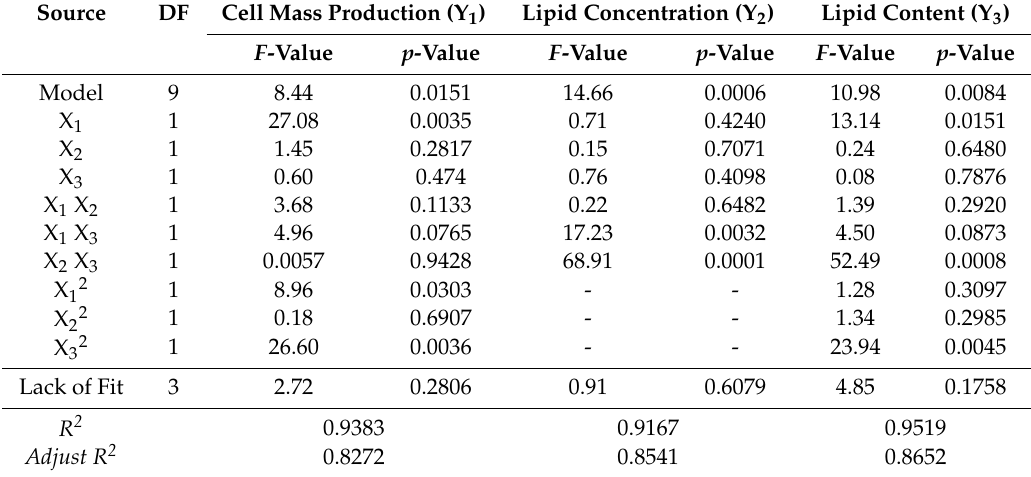
Table 4. Analysis of variance for the quadratic response surface model in the second stage cultivation